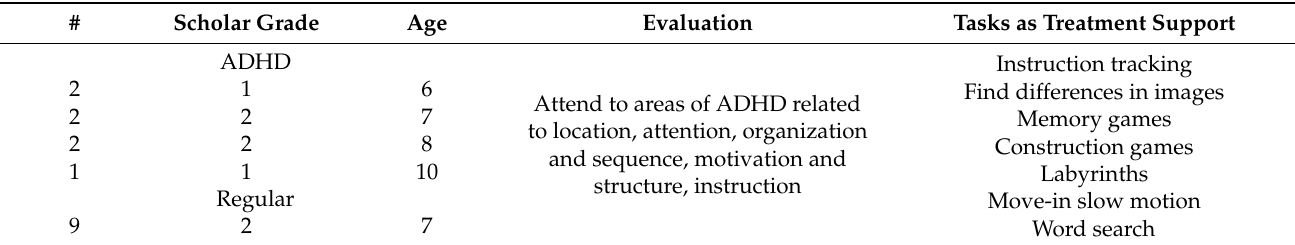
Table 3. User profile of children with ADHD and regular children at elementary school